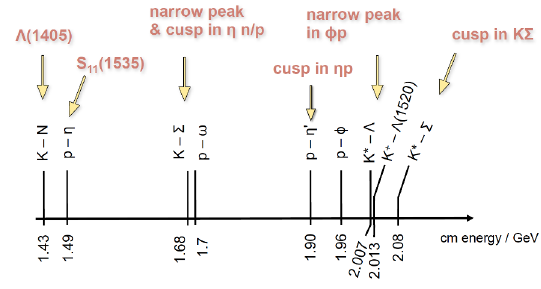
Figure 1. Overview of thresholds and associated pecularities in meson